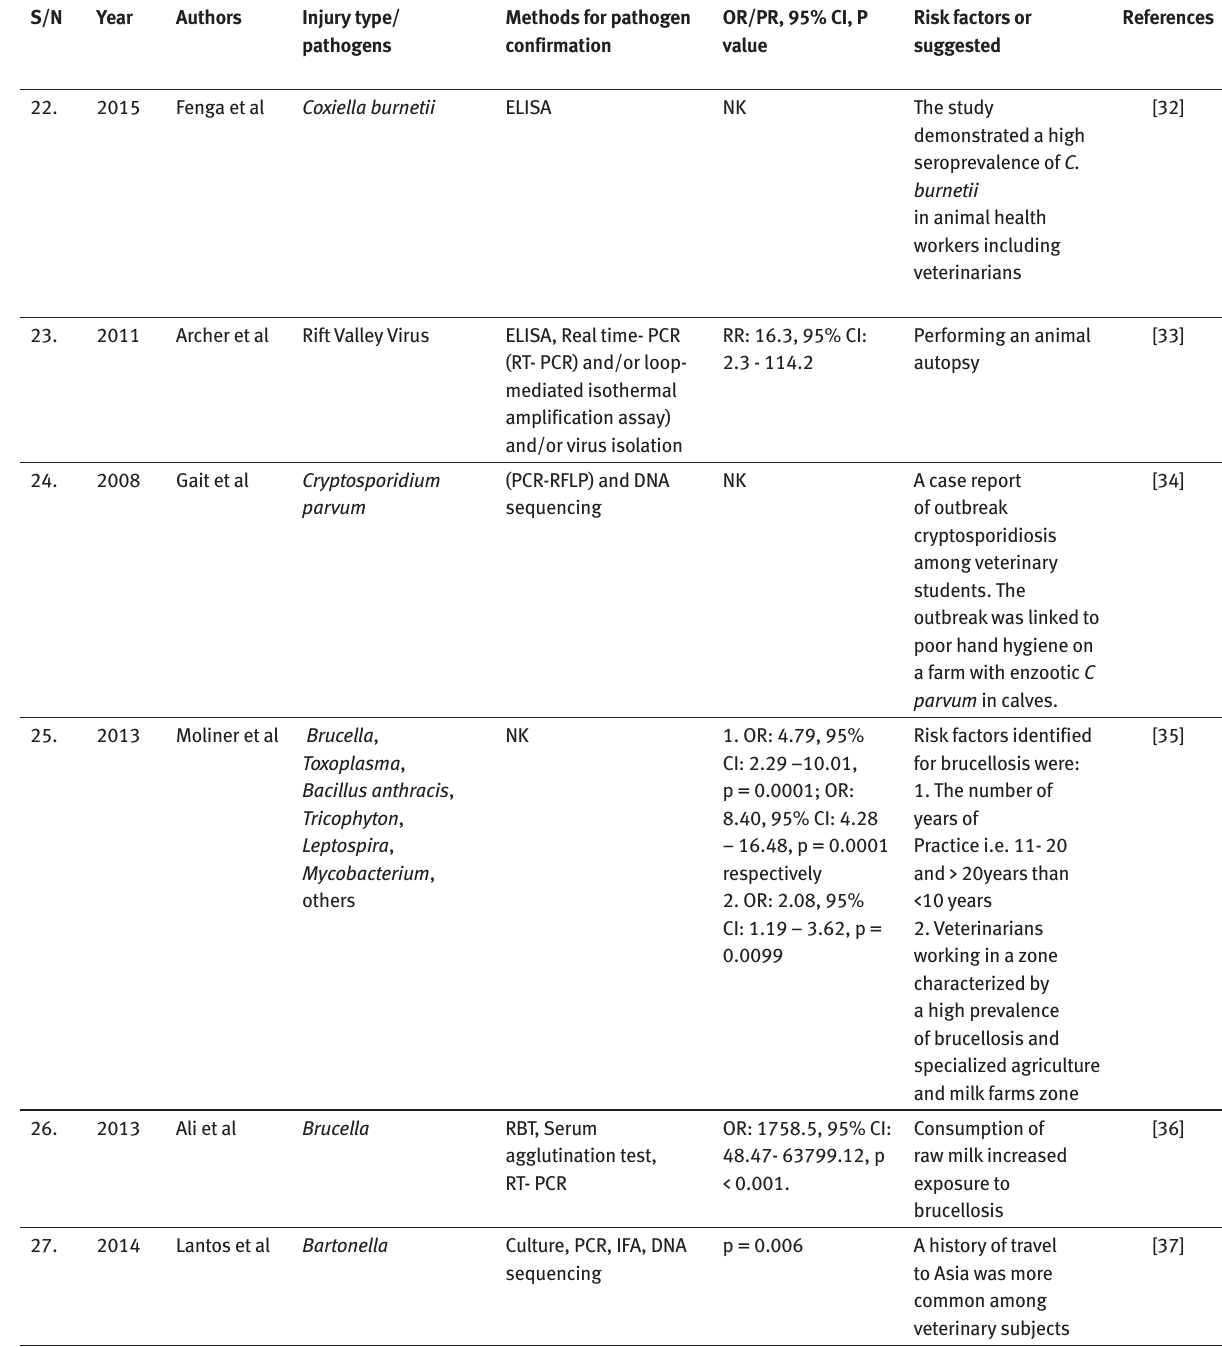
cumulative trauma disorders among the veterinarians (Figure 5). Meta-analysis was done for only working or contact with animals as a risk factor for occupational hazards among veterinarians (Figure 6). The pooled odds ratio for